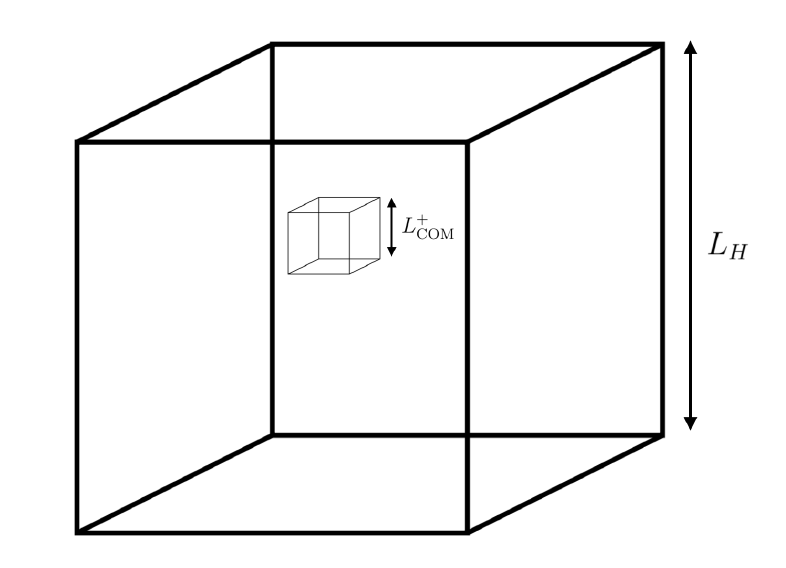
-size cubes. Every such cube contains a single COM